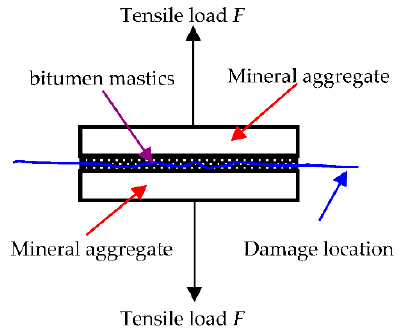
Figure 5. Test principle of bitumen mortar cohesive strength.